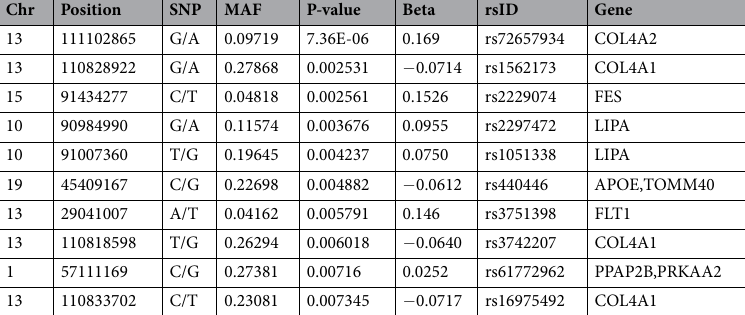
Table 4. Top ten hits for single variant analysis of CAD GWAS gene variants.